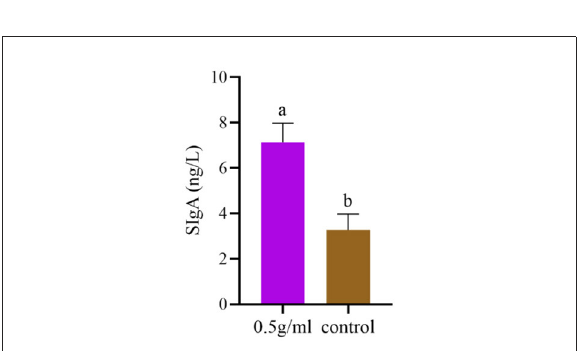
FIGURE4 Effects of orally administered DBD on intestinal SIgA antibody content in the duodenum of mice. a,b Values in the same column with different superscript letters differ significantly at P < 0.05